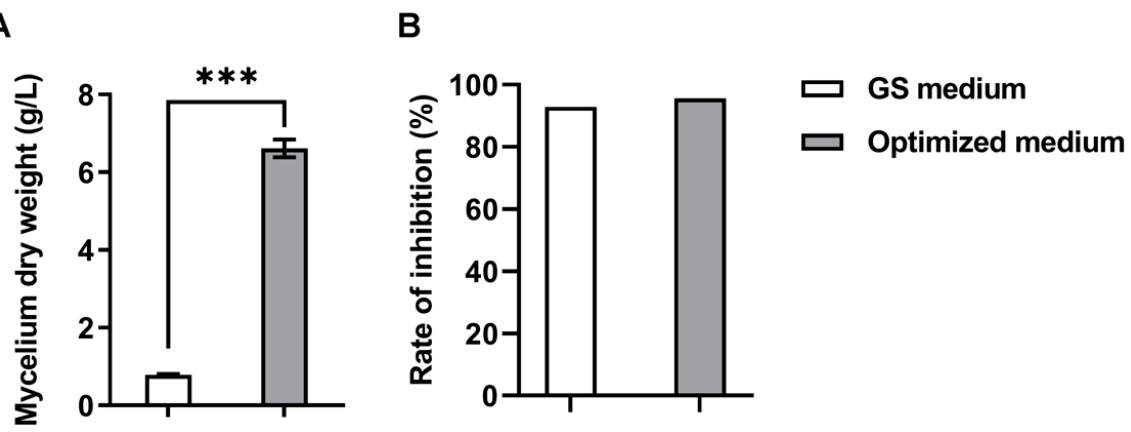
Figure 4. Validation of statistical optimization medium and the initial medium (GS medium). ( A ) Mycelial dry weight. ( B ) Rate of inhibition. Bars represent the SD of three replicates. *** in- dicates statistical significance based on the two-tailed test ( p <